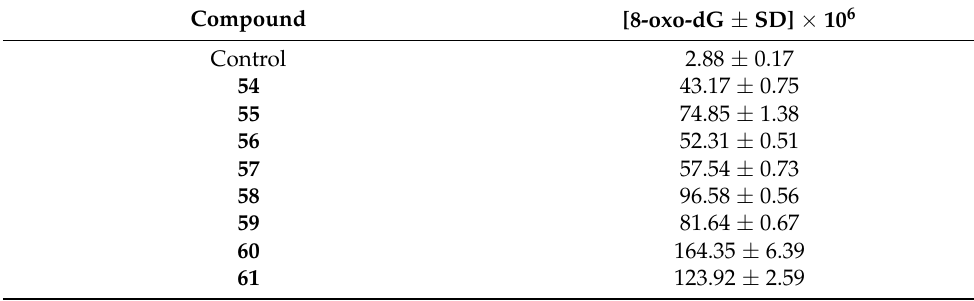
Table 3. 8-Oxo-dG level in cellular DNA after treatment with compounds 54 – 61